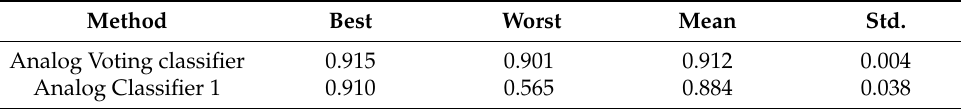
Table 3. Monte Carlo Analysis, classification accuracy.